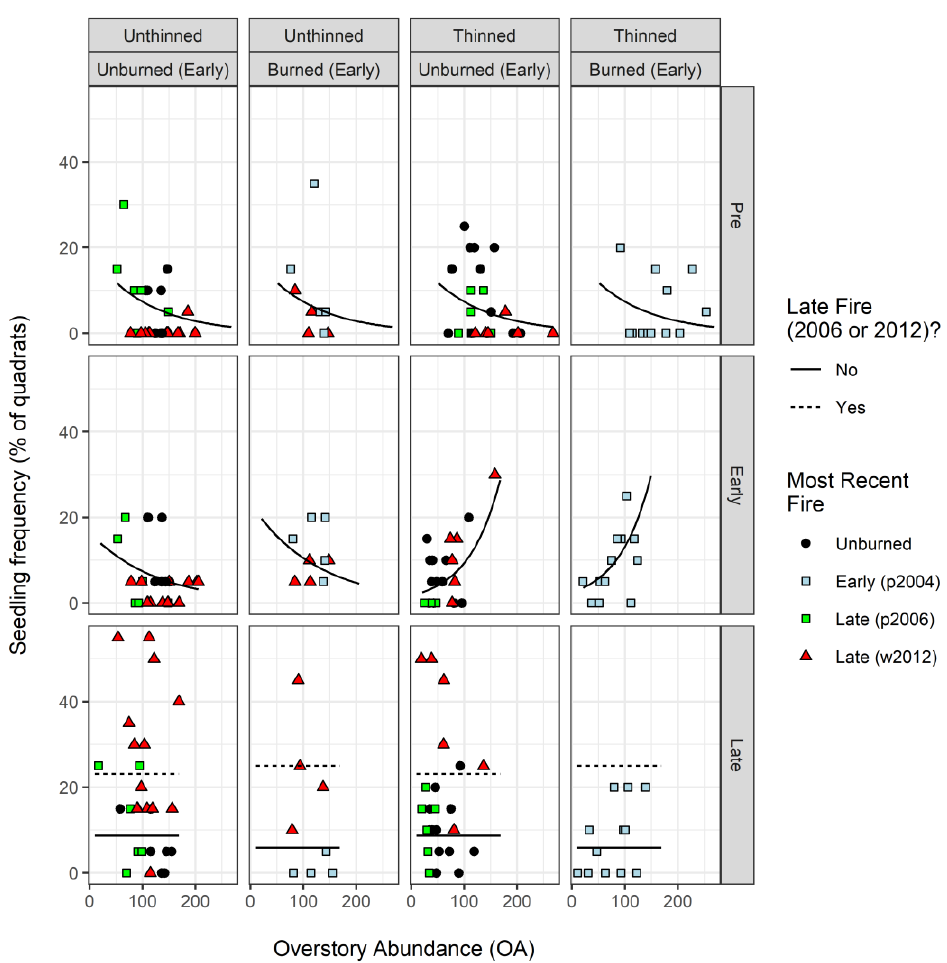
Figure 4. Frequency of seedlings ( < 1 m tall) in the Pre (2000 / 2001), Early (2005), and Late (2015) samples. Values are % of quadrats per plot. Plot values of OA vary by sampling date; horizontal lines indicate no relationship with OA. See Figure 3 for other details and Table 2 for statistical results.